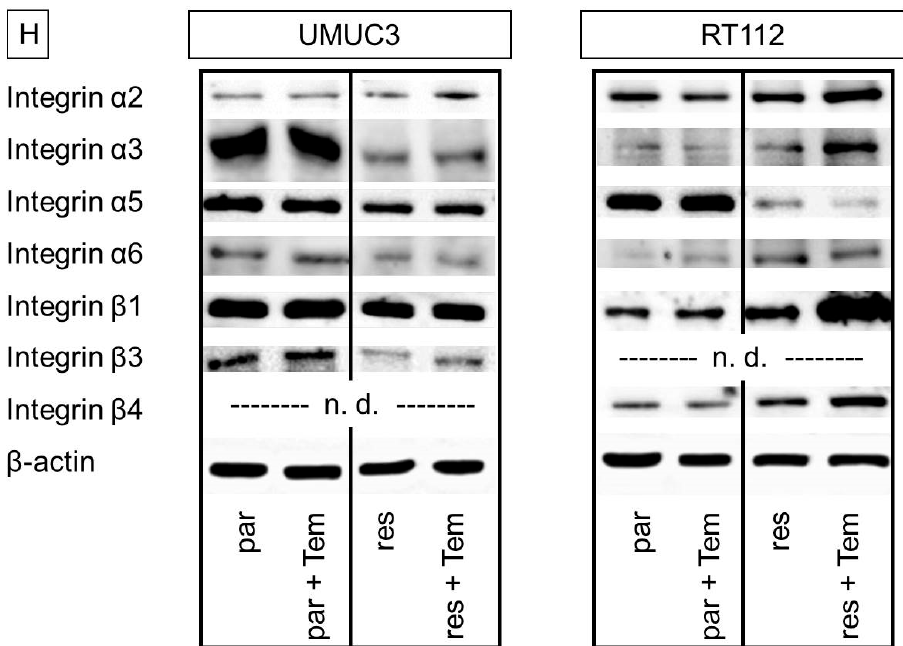
Figure 9. Total integrin content. ( A – G ) Pixel density analysis of the protein expression in parental and temsirolimus-resistant UMUC-3 and RT112 cells exposed to temsirolimus for 72 h. All values are given in percentage di ff erence to the parental control (set to 0). T = parental cells + temsirolimus, R = resistant cells, R + T = resistant cells + temsirolimus. Di ff erences to the parental control (set to 0) are shown. Bars indicate standard deviation (SD). * indicates significant di ff erence to parental control, p ≤ 0.05. n = 4. β -actin served as internal control for western blotting. ( H ) Original western blots: One representative of four separate experiments is shown. Each protein analysis was accompanied by a β -actin loading control. One representative internal control is shown here.